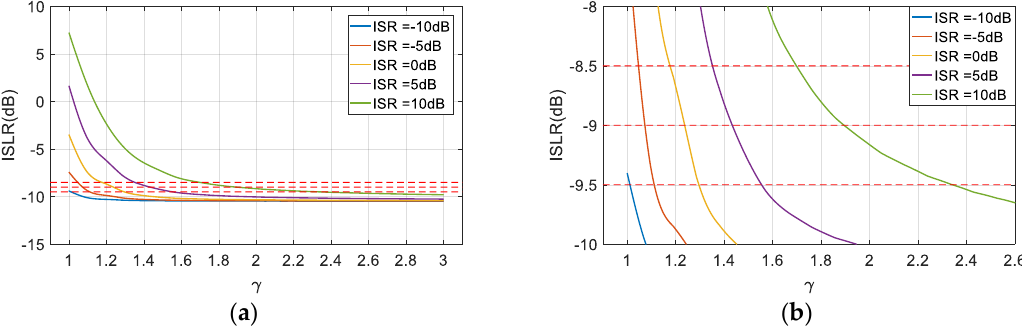
Figure 7. The desired broadening factor under different ISRs. ( a ) The relationship between the broadening factor and the ISLR under different ISRs, original result; ( b ) local enlargement of ( a ).